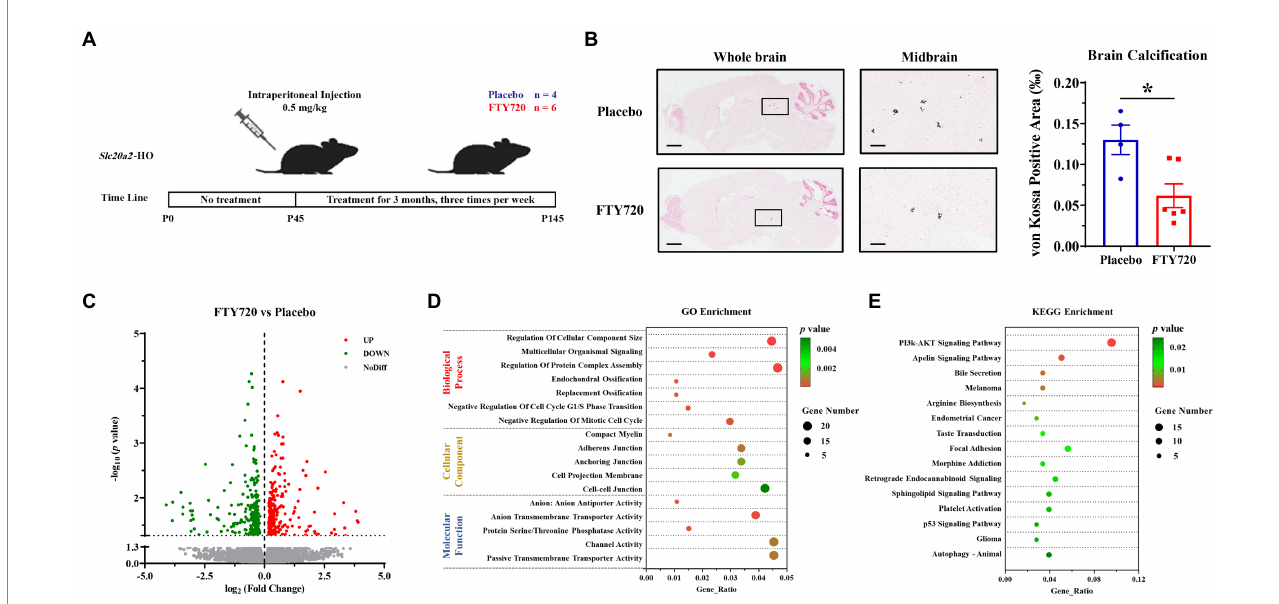
FIGURE 4 FTY720 alleviated brain calcification and mRNA profile analysis. (A) A schematic diagram of the FTY720 administration process. (B) Representative images of brain calcification between placebo- and FTY720-treated mice. Area of decreased brain calcification in FTY720-treated mice compared to the placebo group. Scale bars, 1,000 μ m, 150 μ m. * p < 0.05. (C) A volcano plot for the DEGs revealed by RNA-seq, in which 259 and 223 genes were upregulated and downregulated, respectively, with p < 0.05 as the cut-off criteria. (D,E) GO and KEGG enrichment analyses of the DEGs, with p < 0.01 and 0.05 as the cut-off criteria,